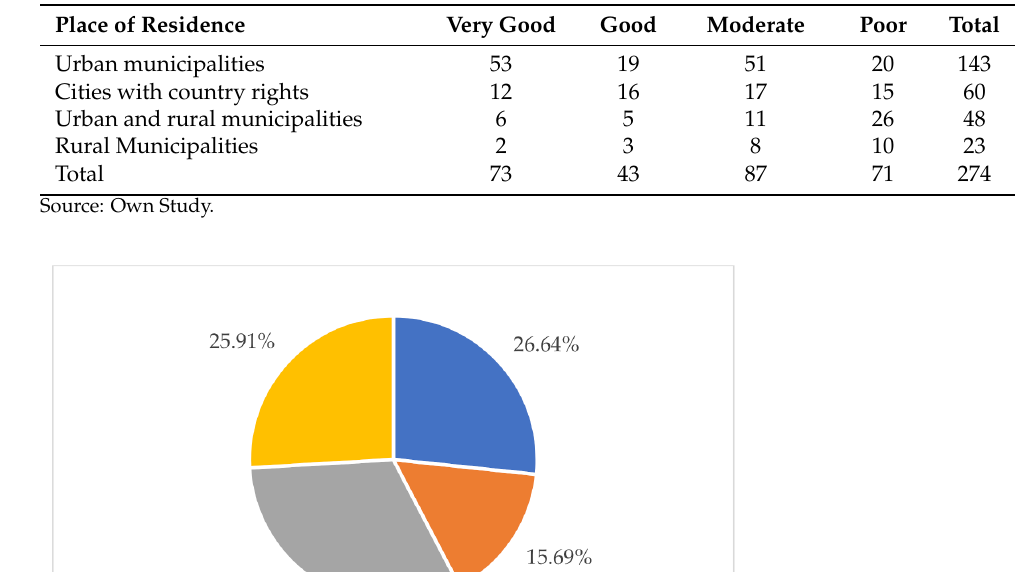
Table 2. Residents’ knowledge of the EU climate and energy policy assumptions.